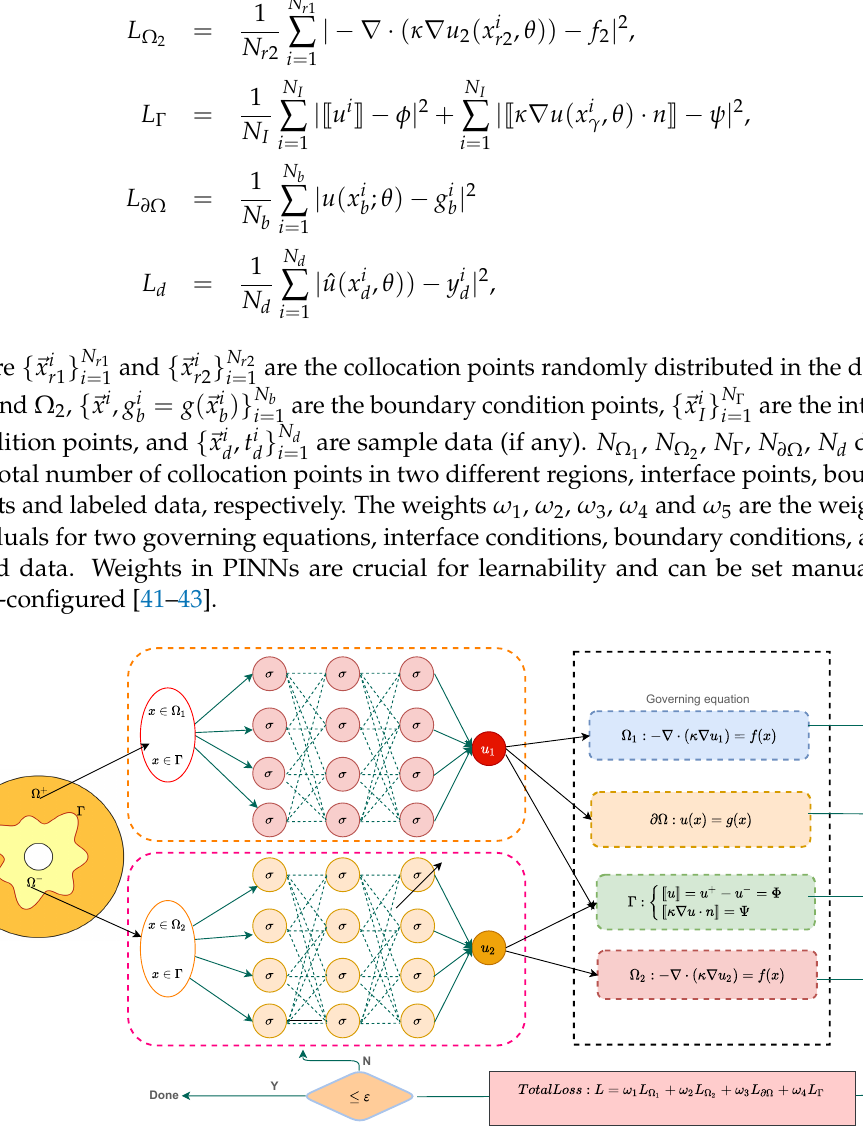
Figure 1. Schematic duel PINNs for interface problems. Two independent neural networks are constructed to approximate solutions to two subdomains,